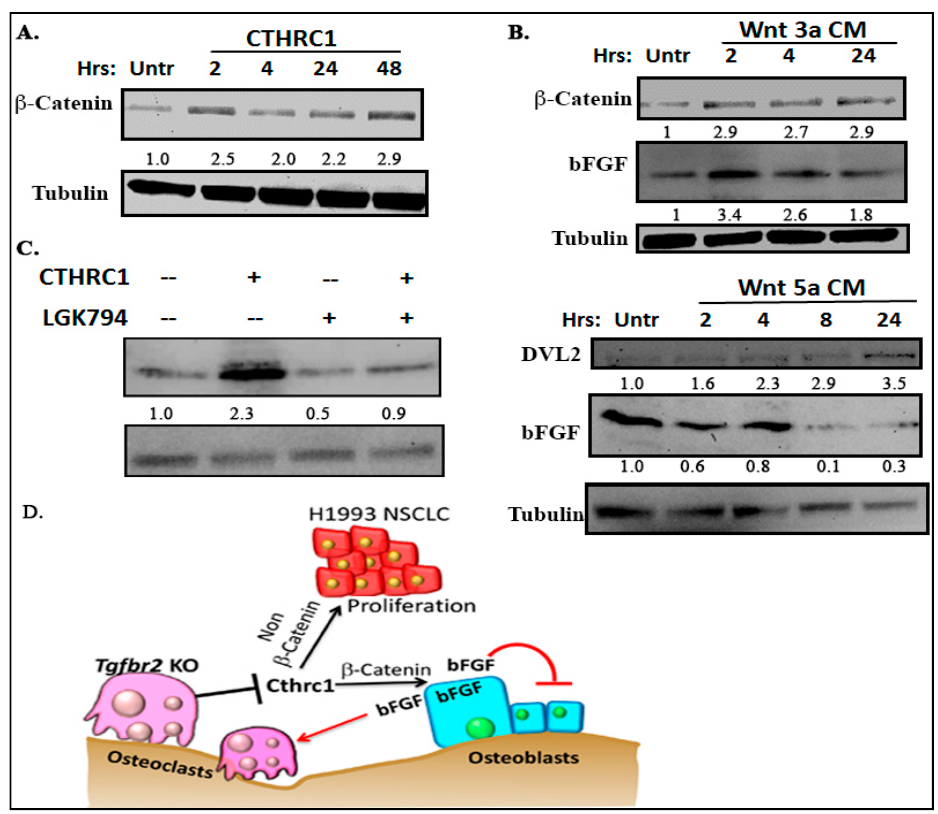
Figure 6. CTHRC1 promoted bFGF in a Wnt/ β -catenin-dependent manner. Western blots of primary osteoblasts that were treated for various times with CTHRC1 ( A ), Wnt3a-conditioned medium ( B , upper panel), Wnt5a-conditioned medium ( B , lower panel), or CTHRC1 with LGK-974 (1 nM/mL) ( C ). The changes of β -catenin and DVL-2 indicate the activation of canonical Wnt pathway, such as by CTHRC1 or Wnt3a, and of the non-canonical Wnt pathway, such as by Wnt5a, respectively. Numbers under each blot are relative quantification of the densities normalized to tubulin. Total cell lysates were used for blotting. Experiments were repeated at least three times with same results. More than 12 mice were used for collecting bone marrows. ( D ) Working model. Loss of TGFBR2 in osteoclasts decreased the expression and secretion of CTHRC1, which stimulated bFGF, possibly through promoting Wnt/ β -catenin signaling. Functionally, bFGF stimulated osteoclastogenesis, but inhibited osteoblastogenesis. On the other hand, CTHRC1 could stimulate H1993 cell proliferation, possibly through non- β -catenin signaling and